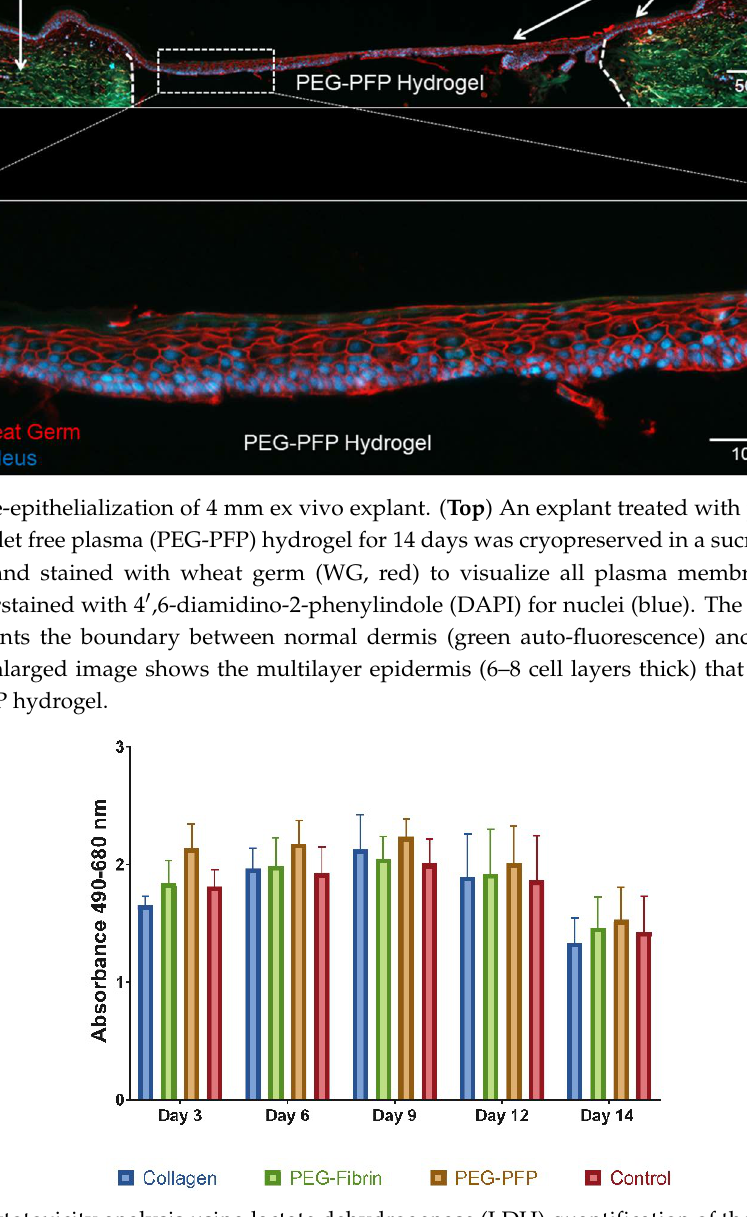
Figure 3. Cytotoxicity analysis using lactate dehydrogenase (LDH) quantification of the supernatant of the treated wounds over time. Media was collected and replaced every 3 days. Cell viability between treatment groups was similar and no statistical differences were observed between any of the treatments or time points ( N = 5 samples).